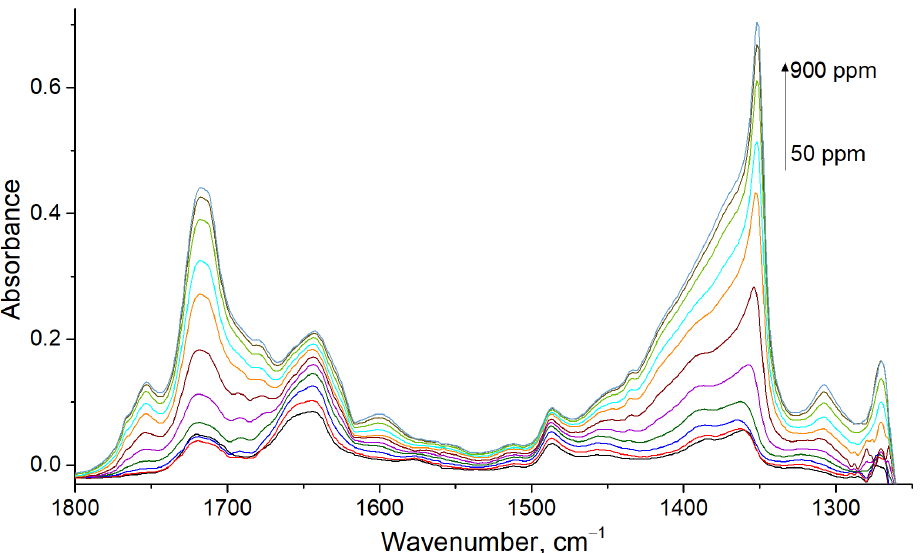
Figure 5. FTIR spectra of NO 2 detected by Sn-BEA: 50 ppm (black), 75 ppm (red), 100 ppm (blue), 200 ppm (green), 300 ppm (purple), 400 ppm (dark red), 500 ppm (orange), 600 ppm (light blue), 700 ppm (light green), 800 ppm (brown), 900 ppm (silver).